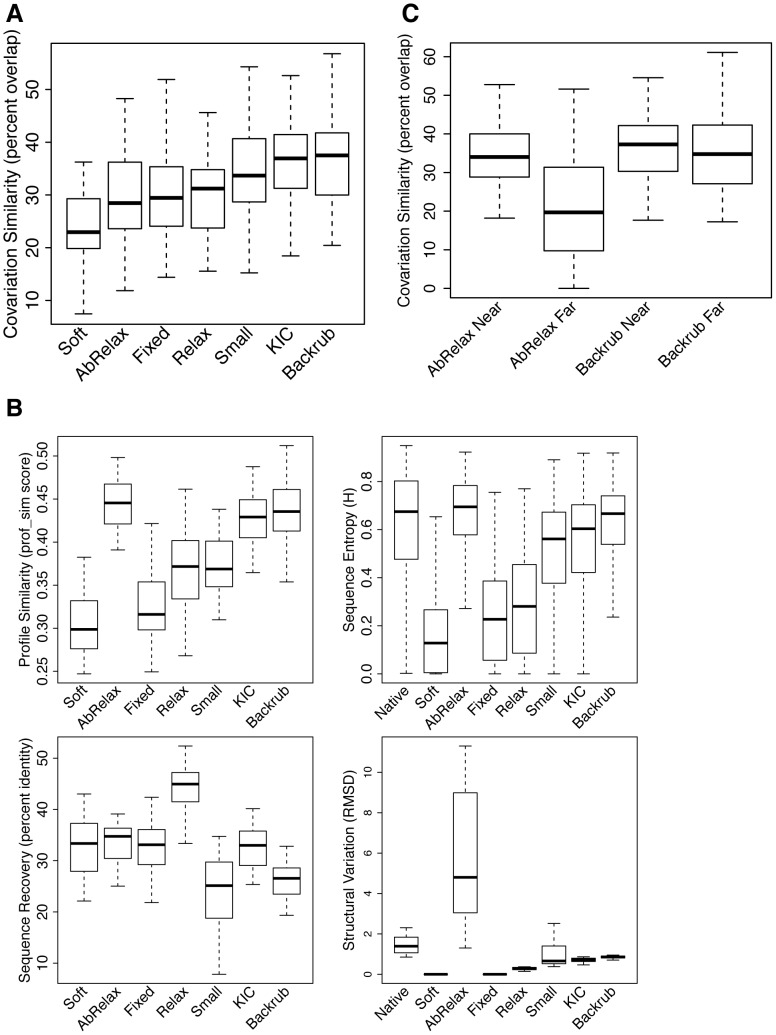
Effects of the mechanism of structural variation on sequence properties.A) Box plot showing the distributions of covariation similarity values between natural sequences and sequences designed using conformational ensembles generated with different methods. The Backrub, KIC and Small simulations shown here were run with kT values of 0.9, 1.2, and 1.2, respectively (which represents the optimal temperature for covariation similarity in each case, see Figures 2B and S2). B) Box plots showing the distributions of sequence and structural characteristics for each method of generating conformational ensembles. C) Covariation similarity distributions for subsets of covarying pairs that are “near” in sequence (separated by 10 residues or fewer) or “far” in sequence (separated by greater than 10 residues).